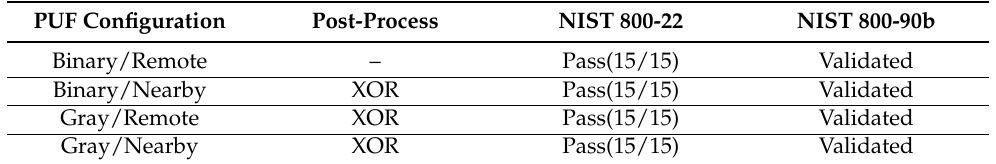
Table 8. Summary of TRNG randomness assessment results and their validation as a source of